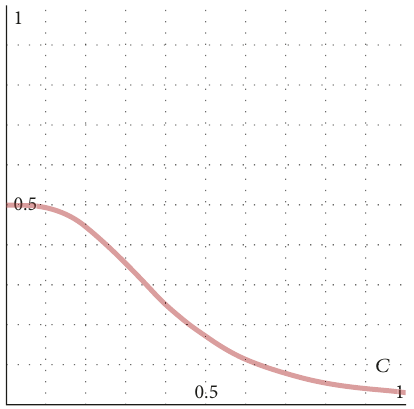
Figure 5: A typical profile of ℎ(𝑐) with 𝐾 𝐷 = 0.5 , 𝑚 1 = 3 , and 𝑐 𝑐𝑟𝑖𝑡2 = 0.4